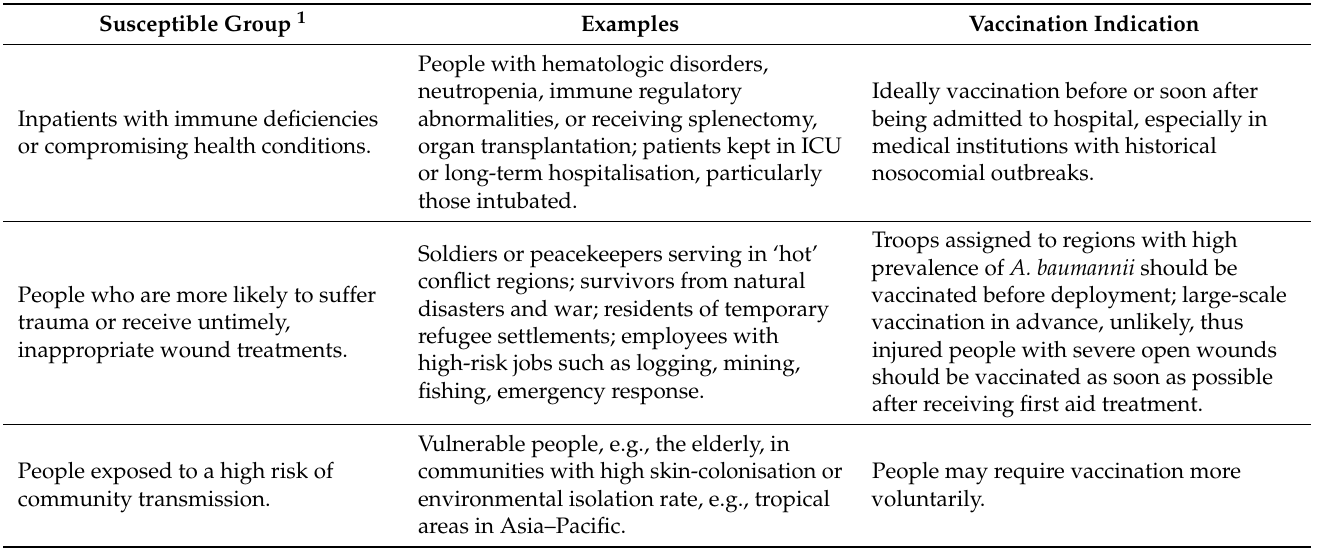
Table 2. Target Populations of A. baumannii